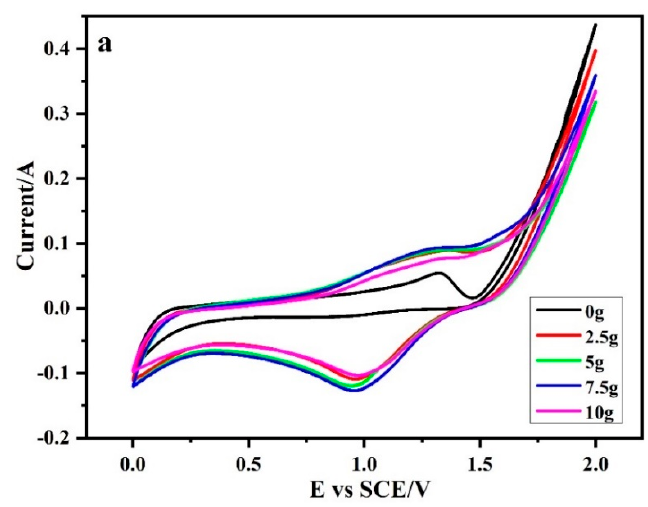
Figure 3. The cyclic voltammetry curve of 2.5D electrode system under different Sb–SnO 2 magnetic particle dosage.